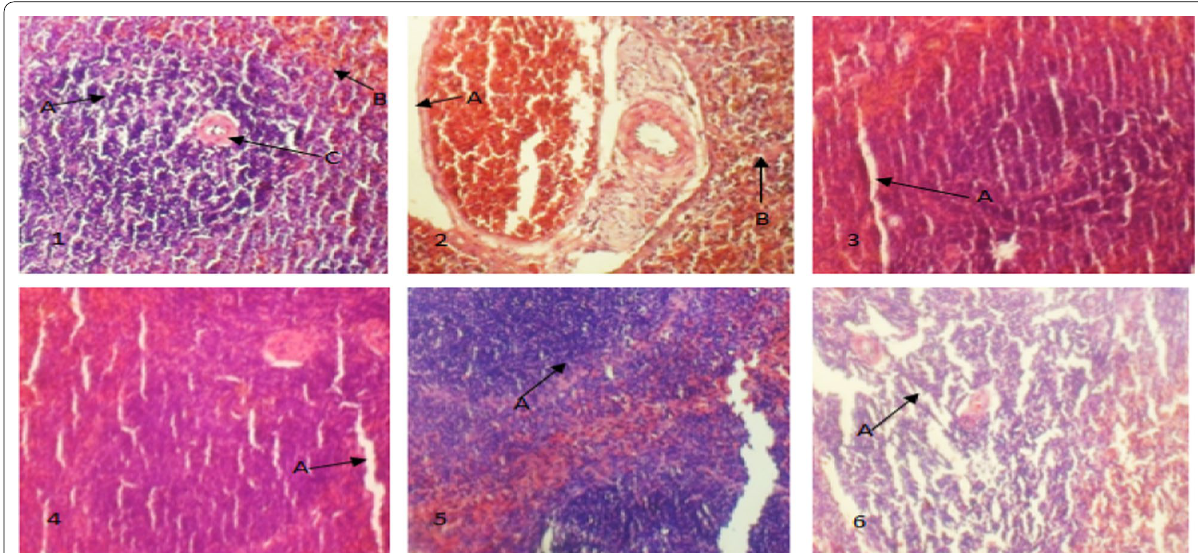
Fig. 11 Effect of n-hexane leaf extract of Ipomoea batatas L . on the spleen. (1 ) The c ontrol Rat spleen represented with A as white pulp, B as red pulp and C as arteriole, (2) phenylhydrazine alone showed A—severe sinus dilation and B—moderate follicular atrophy, (3) at 5 mg/kg of ferrous (iii) hydroxide poly-maltose showed A—mild follicular atrophy, (4) at 125 mg/kg n-hexane showed A—normal follicular architecture (5) 250 mg/ kg n-hexane showed A—normal follicular architecture and (6) 500 mg/kg n-hexane showed A—normal follicular architecture. They were using